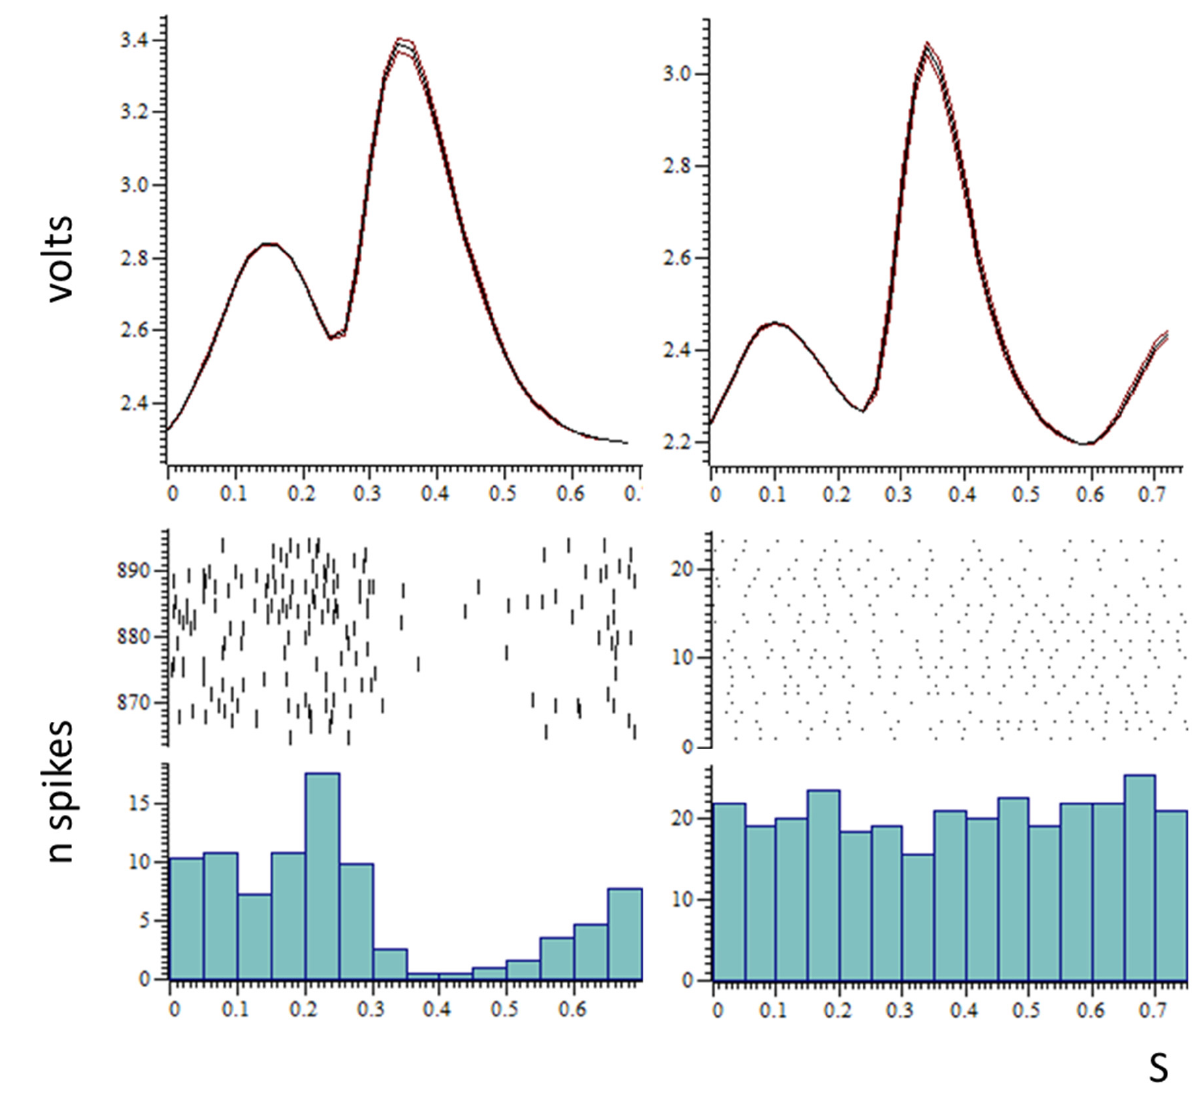
Figure 2. Examples of spontaneous activity in ventral striatal neurones in phase with ( left column ), or independent of ( right column ), the respiratory cycle. Top graphs: average (mean +/ − SEM) of a respiratory cycle computed over 30 s, inspiration (1st part of the curve, low amplitude) then expiration (2nd part of the curve, high amplitude). Bottom graphs: upper part, single neurone raster and lower part, peristimulus time histograms (bin width 50 ms) of spontaneous activity (n spikes) computed over the same 30 s period. X axis time in seconds. Left column: this neurone became nearly silent during expiration. Right column: this neurone’s spontaneous activity was independent from respiration.